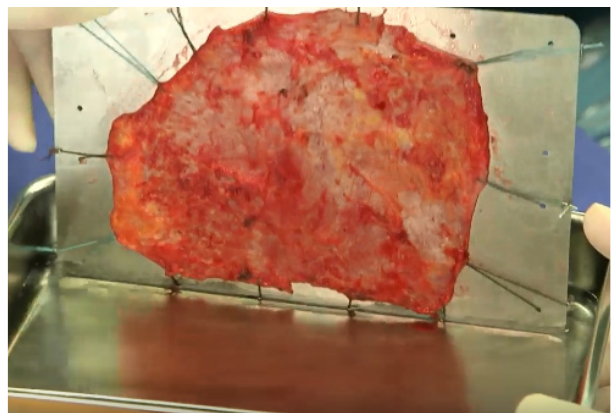
Fig. 1 – Glutaraldehyde-treated autologous